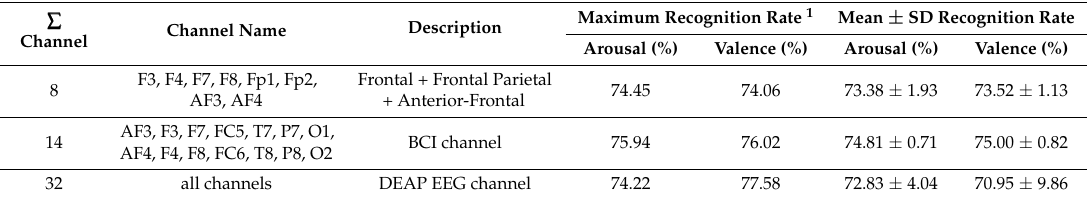
Table 4. Channel selection and